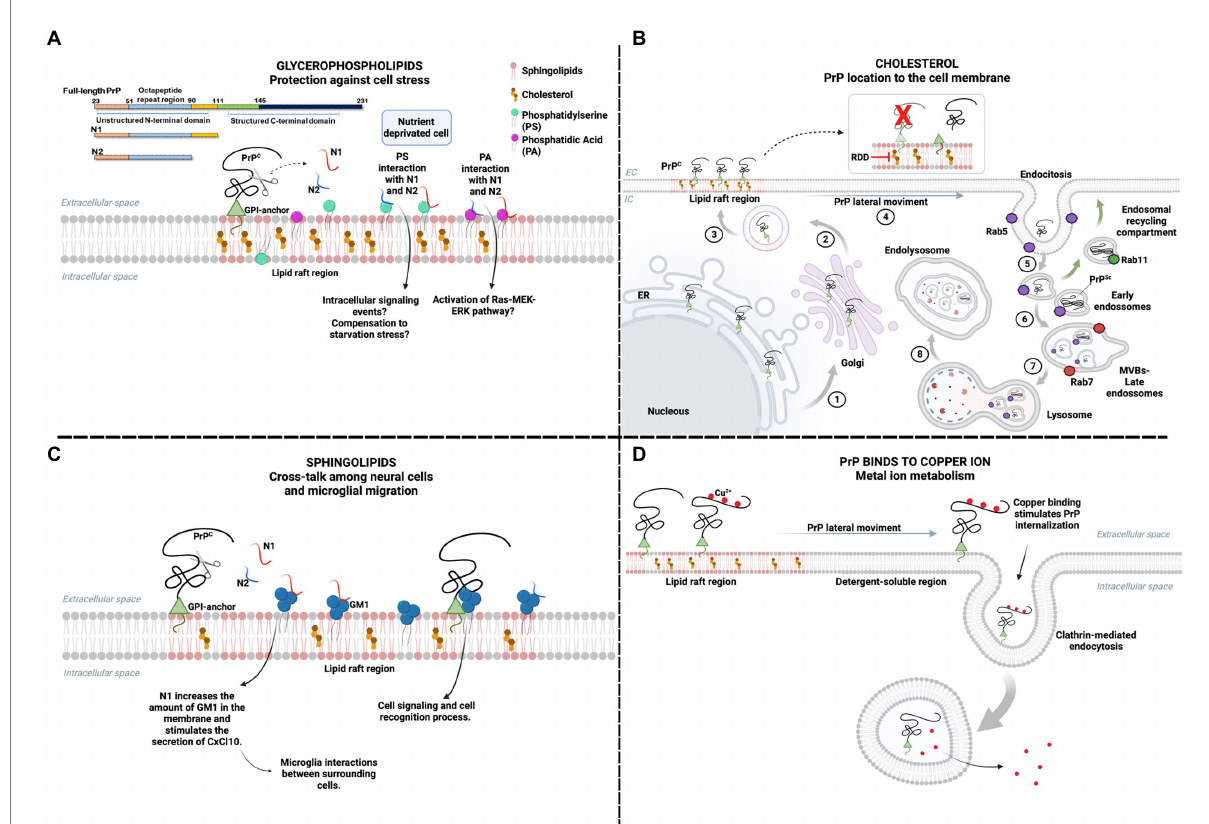
FIGURE 1 The physiological effects of PrP interaction with membrane lipids. Location on lipid rafts enables PrP C interaction with various ligands, including membrane lipids. (A) Cellular starvation can alter the plasma membrane order, leading to PS exposure to the extracellular medium and increased PA. The interaction of N1 and N2 fragments, peptides derived from the proteolytic cleavage of PrP, may have a regulatory effect on cellular stress by binding to PS and PA. The interaction of N1 and N2 with PA can activate the Ras–MEK–ERK pathway and promote cell survival. At the same time, the interaction with PS can also activate pathways related to the same function. (B) PrP C is formed in the endoplasmic reticulum, which undergoes post-translational modifications, such as binding to the GPI anchor. Subsequently, it is taken to the Golgi complex (1) and forwarded to the plasma membrane (2), mainly in lipid rafts (3). The importance of cholesterol in lipid rafts for the physiological location of PrP C has already been reported. The process of internalization of PrP requires a lateral movement (4) to areas where the membrane is more soluble, outside the lipid rafts. Endosome motility is related to the function of Rab proteins, such as Rab 5 for early endosomes (5), Rab 7 for the multivesicular body (MVB)/late endosomes (6), and Rab11 for the endosomal recycling compartment (ERC) (green arrows). Conversion of PrP C to PrP Sc can occur within ERC and MVBs. MVBs fuse to lysosomes (7) and proteins are degraded in endolysosomes (8). The cleavage of PrP C from the GPI anchor may favor PrP-lipid interaction and PrP conversion, but cells expressing PrP without GPI are not infected. Drugs that sequester cholesterol are raft dissociation drugs (RDD), known to inhibit PrP Sc formation. (C) The interaction of GM1 ganglioside and N1 fragment promotes the increase of GM1 in the plasma membrane. It stimulates the secretion of the cytokine CxCl10, enabling the interaction between microglia and other surrounding cells. The interaction between PrP C and GM1 has been reported, but the mechanisms triggered by this interaction have not been elucidated but are possibly related to cell signaling and cell recognition process. (D) PrP C binds to copper ions and is involved in ion metabolism. It has already been reported that the interaction between copper and PrP C stimulates the endocytosis of PrP. In the presence of copper, PrP C leaves the lipid raft region and internalizes mainly via clathrin-mediated endocytosis, balancing the amount of copper inside and outside the cell. Created with